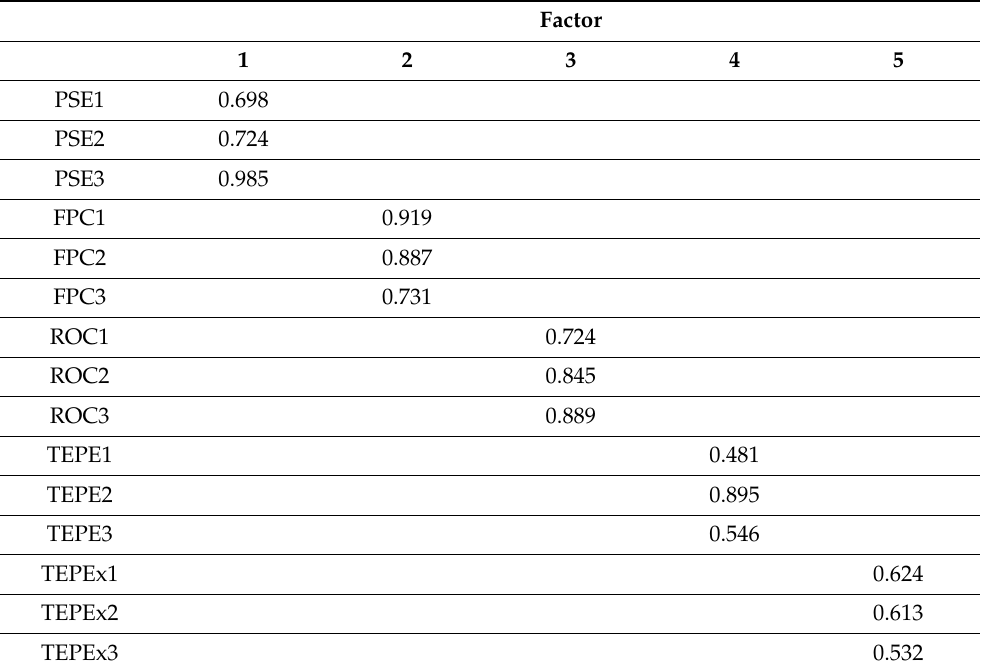
Table 3. Rotated Factor Loading Table for the LTSI Training General Domain (5-Factor Extraction n =